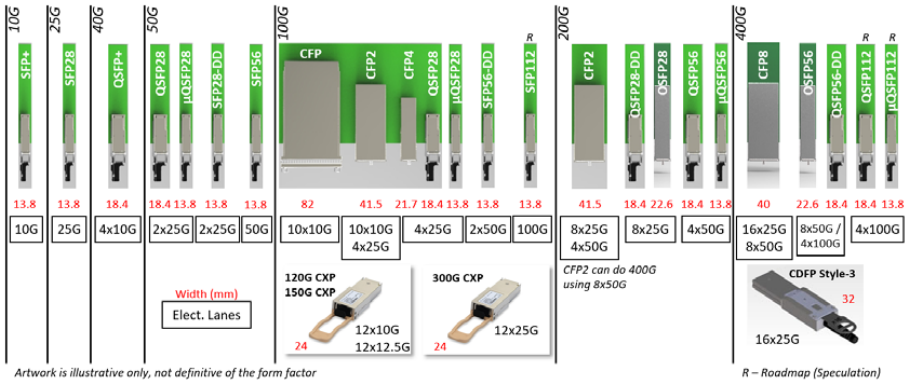
Figure 2. Form factors and electrical lanes for pluggable optical modules.